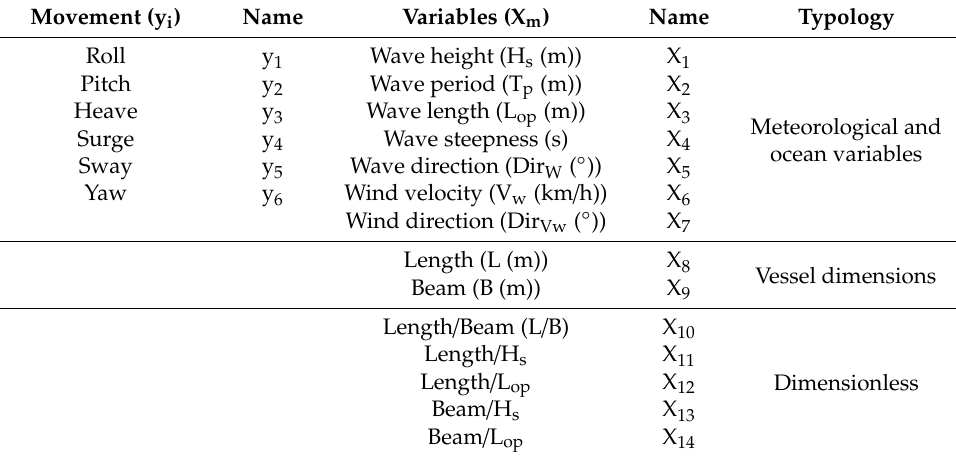
Table 5. Response and predictor variables, with corresponding